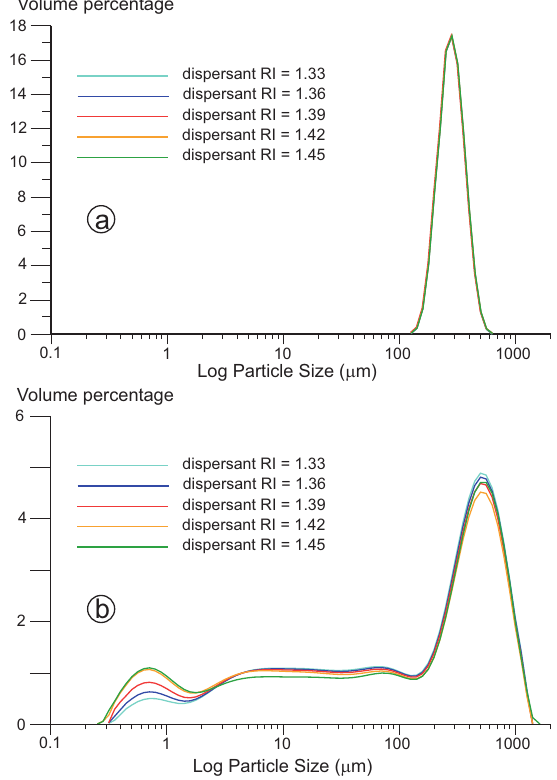
Fig. 24. (a) Granulometric curves obtained by reprocessing the first run data from test MP2500 5 on sub-sample aliquot SAND1c (Fig. 8) using quartz RI=1.5, quartz ABS=0.1, and variable RI values of decalcified tap water from 1.33 to 1.45. (b) Granulo- metric curves obtained by reprocessing the first run data from test MP2000 5 on sub-sample aliquot CABRE3d (Fig. 9) using calcium carbonate RI=1.6, quartz ABS=0.01, and variable RI values of de- calcified tap water from 1.33 to